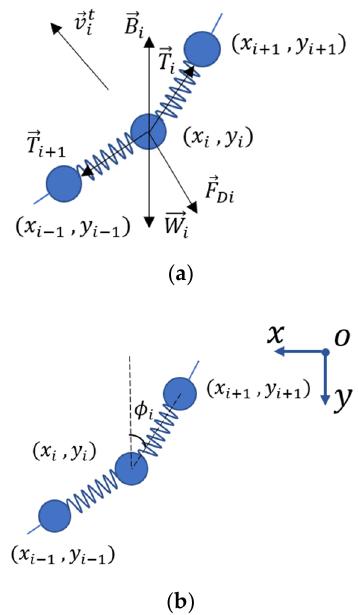
Figure 7. ( a ) Force analysis on node i and ( b ) position of each nodes.